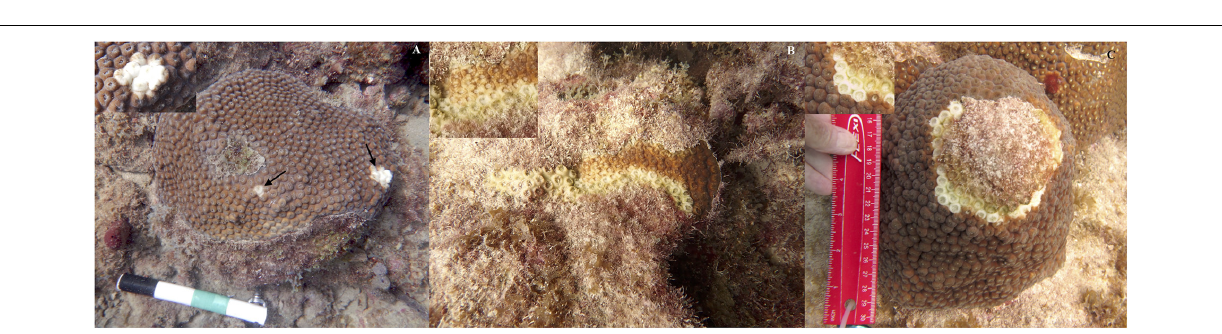
FIGURE 5 | SCTLD prevalence on tagged M. cavernosa colonies in Fort Lauderdale during year one ( n = 23; A) and year two ( n = 20; B) of the study, and on tagged M. cavernosa colonies in the Lower Keys during year one ( n = 17; C) and year two ( n = 14; D) of the study.